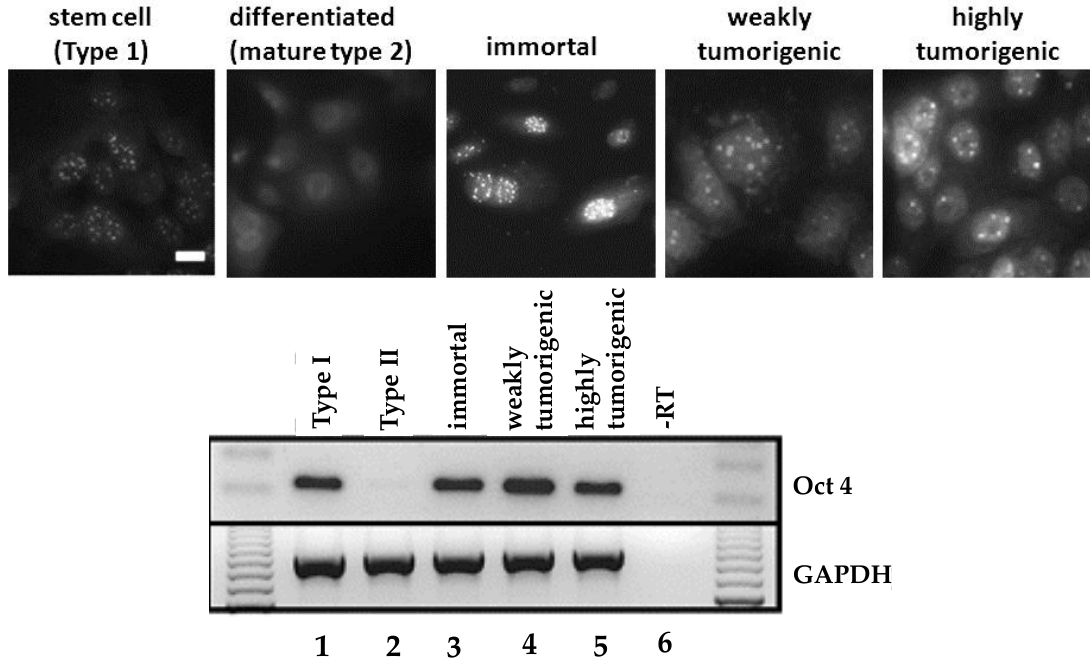
Figure 9. The composite of these figures illustrated that (a) the clonally derived normal human adult breast stem cells expressed Oct4+ or Type 1 via immuno-histochemical use of fluorescent antibodies to Oct4 in the normal breast stem cells, but not in the differentiated breast cells, still expressed in SV40 immortalized normal breast stem cells that were not tumorigenic, still expressed in the irradiated and weakly tumorigenic breast stem cells, and expressed in the neu/ErB-2 highly transformed clone. The RT-PCR data correlated with the immune-histochemical data of Oct4 in this series of human breast adult stem cells. Type 2 or differentiated Type 1 cells were derived from Type 1 or adult human breast stem cells after the Type 1 cells were exposed to cholera toxin (Kao et al. [83]). Permission granted by Karger Publishers.